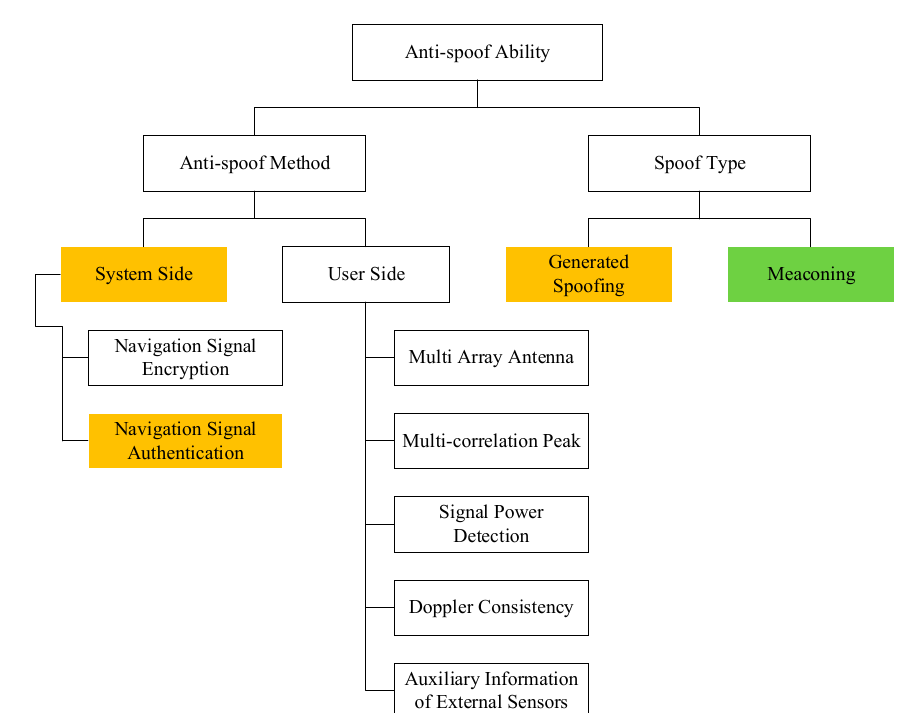
Figure 7. Ability of satellite navigation signal authentication technology.